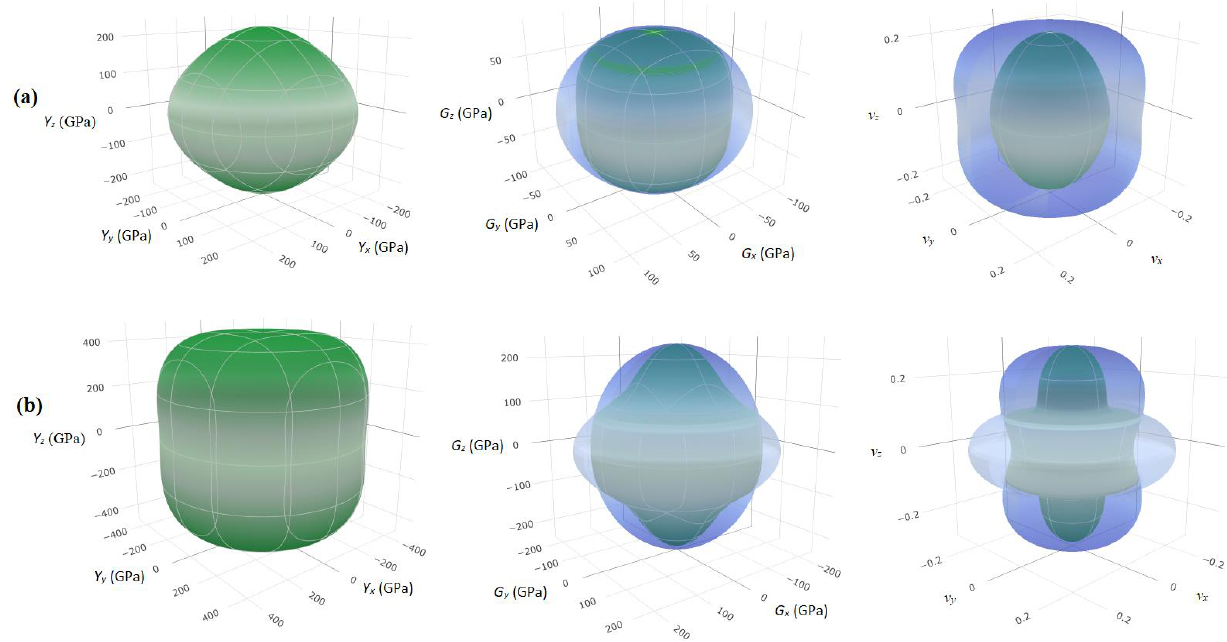
Figure 8. 3D plot of Young’s modulus, shear modulus, and Poisson’s ratio surfaces of Hf 2 PbC at pressure ( a ) 0 GPa and ( b ) 100 GPa.